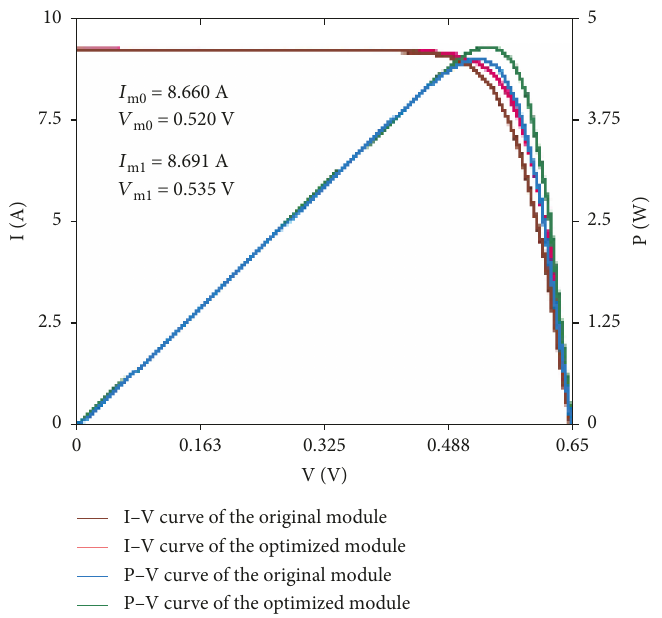
Figure 9: The I – V and P – V curves of the original and optimized